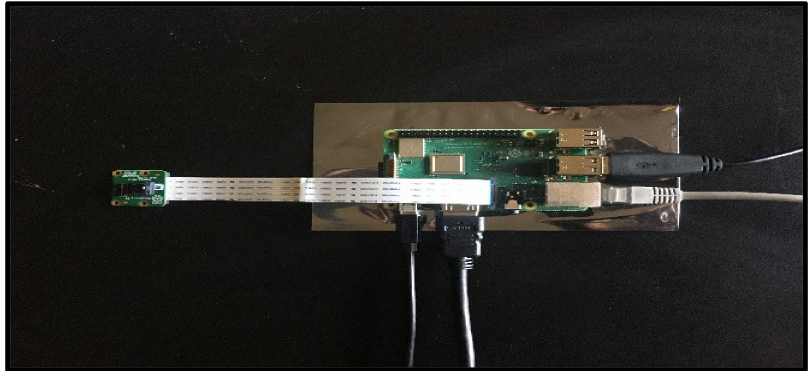
Figure 7. Target